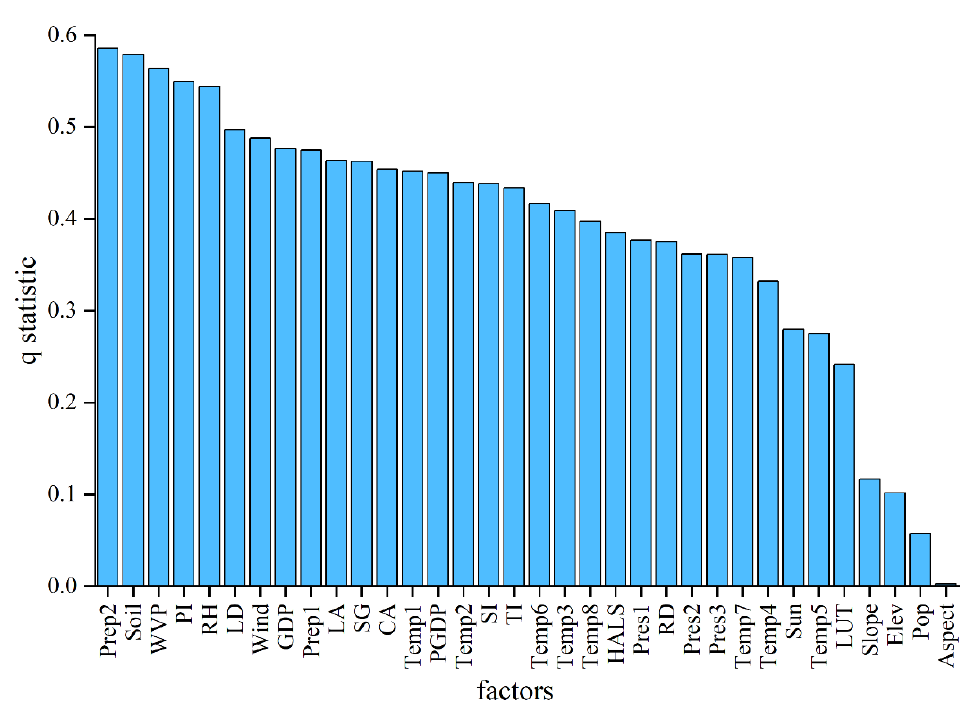
Figure 6. Average q statistics from 2000 to 2019 in Xilingol. The influence of natural conditions dominated the spatial distribution of NDVI, with Prep2 having the strongest explanatory credibility. The interannual variation of 19 factors with q statistics greater than 0.4 was counted, and the results are shown in Figure 7.